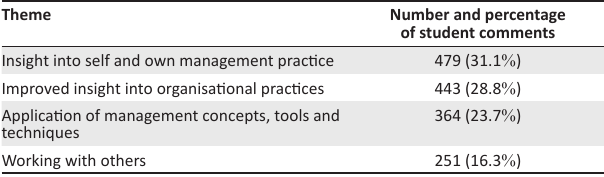
TABLE 1: Student response